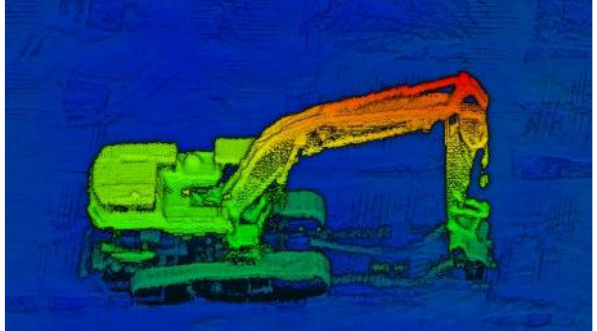
Figure 3. The image shows an example of a high-density point cloud collected by the RedTail LiDAR Systems RTL-450 sensor. Flight Specifications: altitude 30 m, speed 5.8 m/s. Coloring of the point clouds is by altitude.